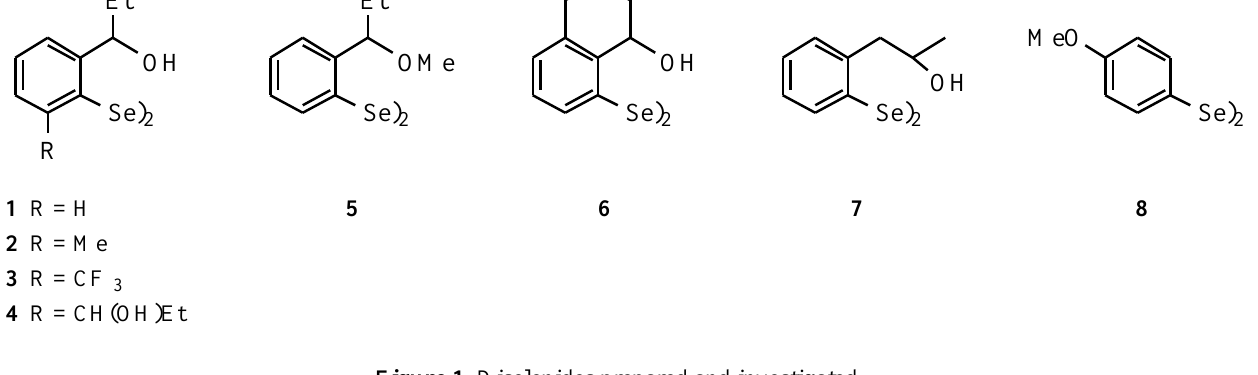
Figure 1. Diselenides prepared and investigated.